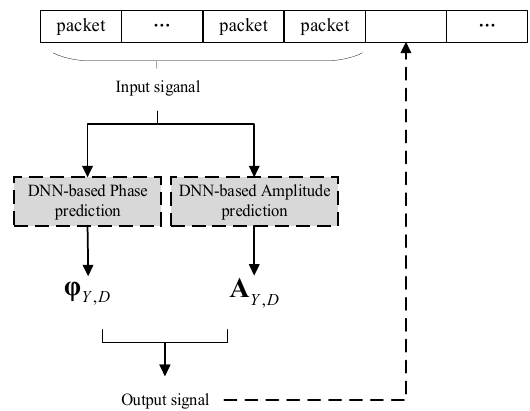
Figure 3. Block diagram of baseline DNN-based PLC